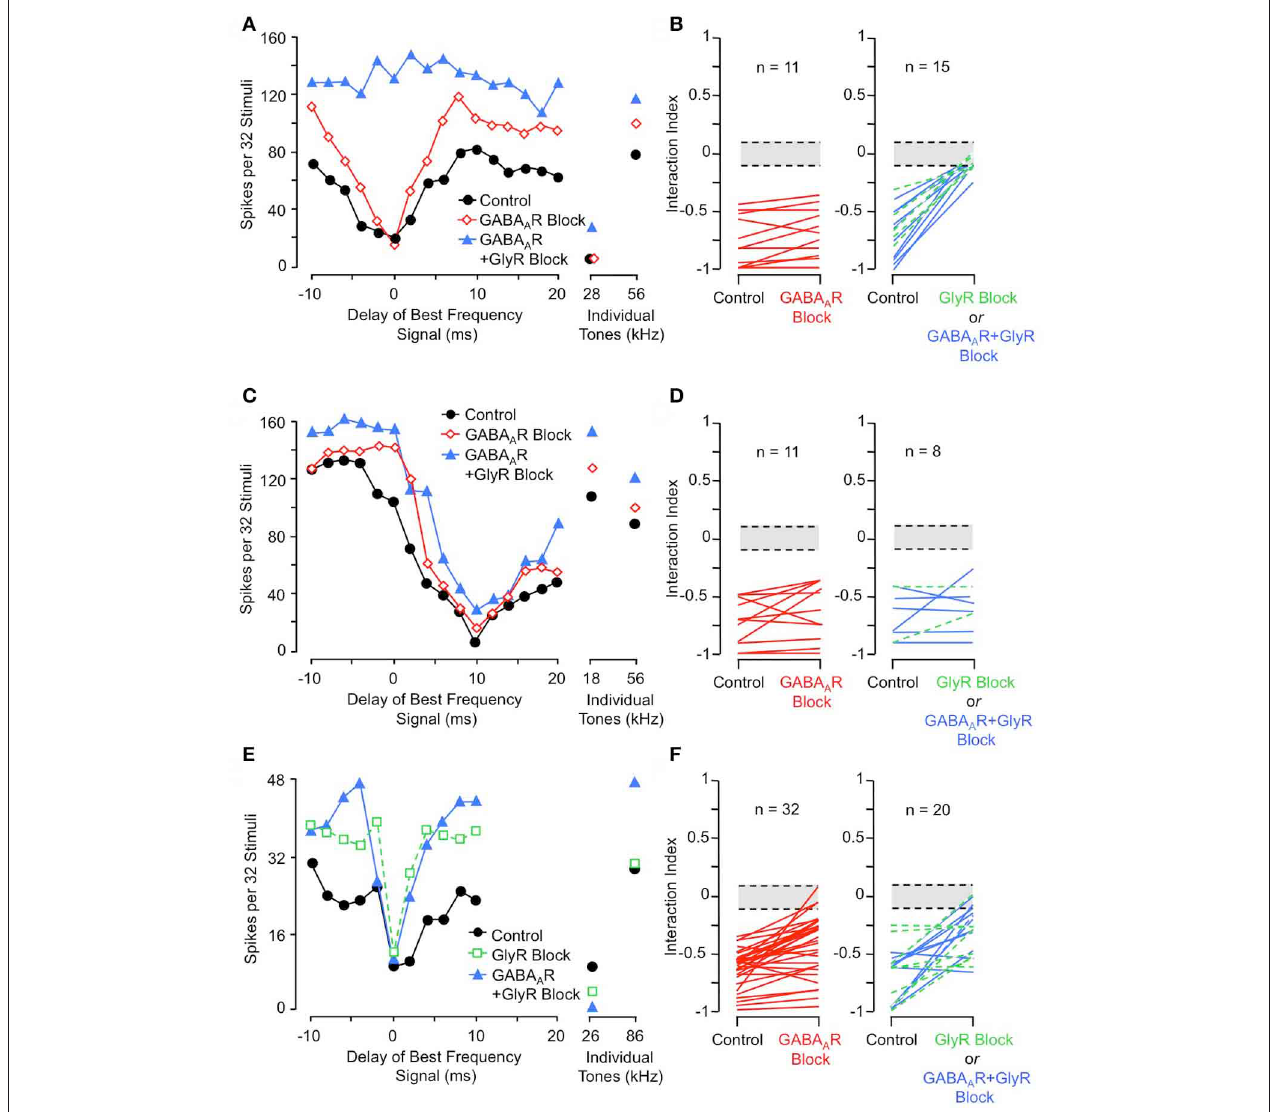
blockade. (C) In same INLL neuron as in (A) , blockade of GABA A R or both GABA A R and GlyR failed to eliminate 18kHz suppression. (D) Effects of receptor blockade on < 23kHz suppression among NLL neurons. Neither GABA A R nor GlyR blockade eliminated suppression tuned to frequencies below 23kHz. (E) In an IC neuron, blockade of GlyR did not eliminate 26kHz inhibition, although the delay function was narrowed. Combination of GlyR and GABA A R blockade failed to eliminate 26kHz inhibition. (F) Effects of receptor blockade on 23–30kHz inhibition among IC neurons. Data suggest that many IC neurons inherit combination sensitivity from auditory brainstem inputs, but that some inhibitory inputs tuned to 23–30kHz terminate onto high-ChF neurons in IC. Adapted from Peterson et al. (2009) (A–D) and Nataraj and Wenstrup (2005, 2006) (E,F) , with